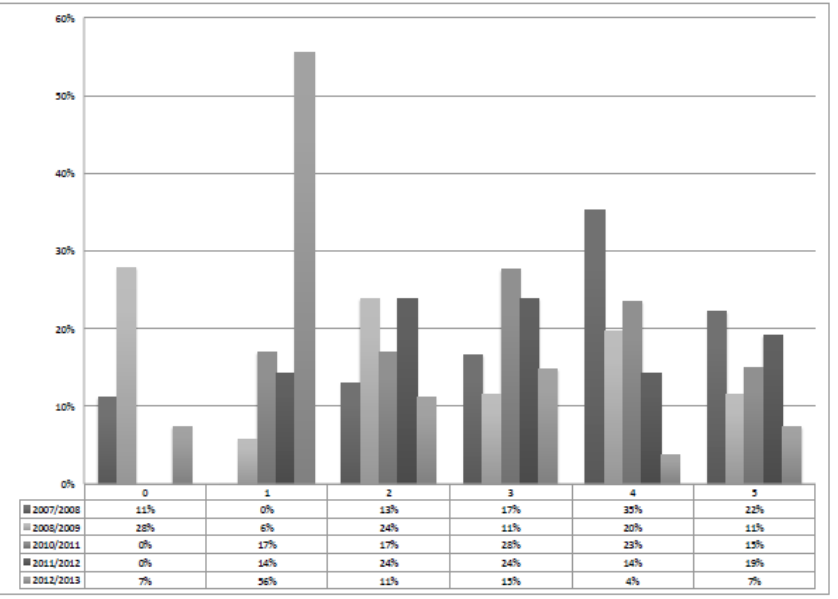
Figure 7. JavaVis Desktop framework is useful for lab assignments